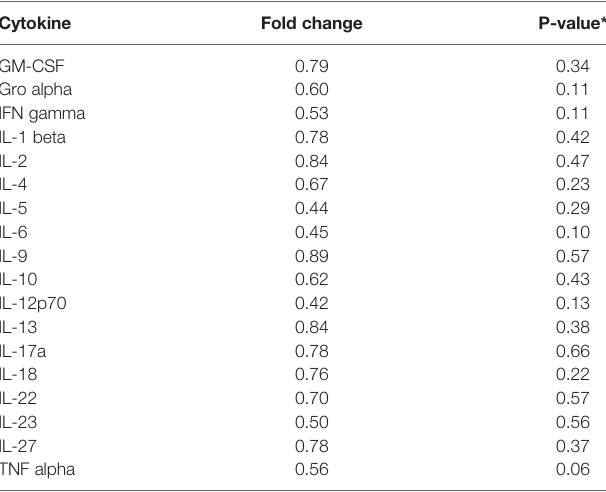
TABLE 5 | Median fold change in secretion of cytokines involved in Th1, Th2, Th9, and Th17 signaling from initiated colon tissues from tumor-bearing vs tumor-free Apc +/Min-FCCC mice.